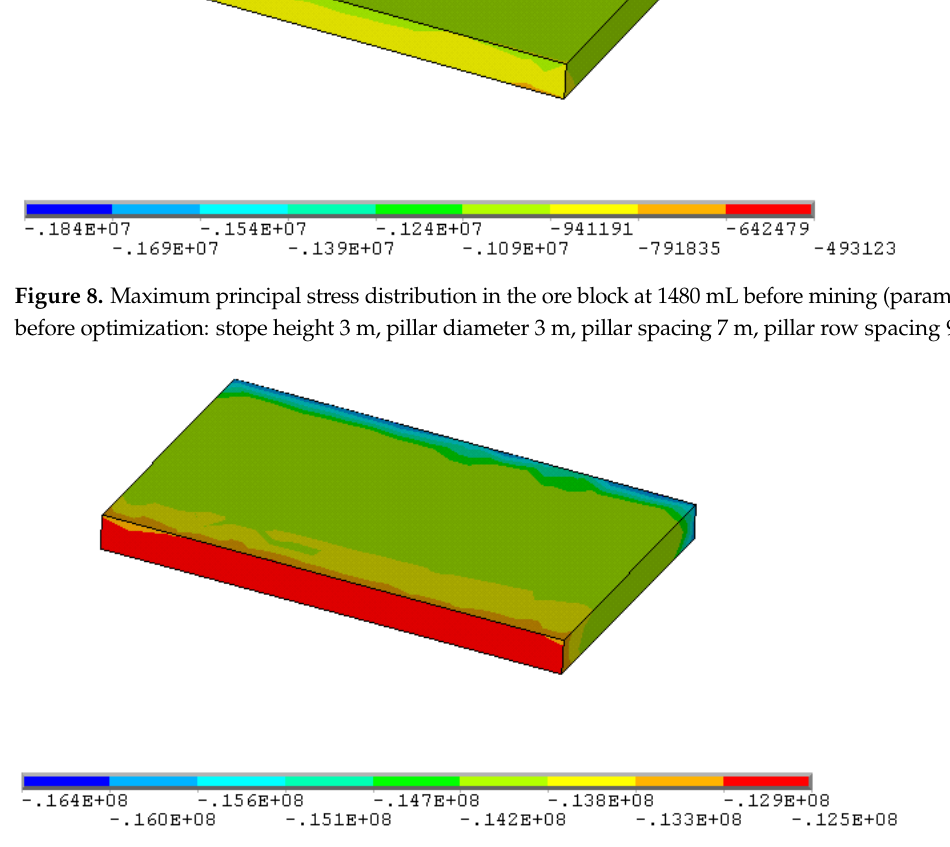
Figure 9. Minimum principal stress distribution in the block at 1480 mL before mining (parameters before optimization: stope height 3 m, pillar diameter 3 m, pillar spacing 7 m, pillar row spacing 9 m).